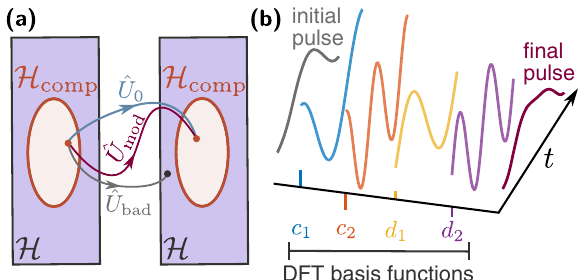
Fig. 1 Generic quantum control problem. a An idealized unitary evolution ( ^ U 0 ) maps an initial quantum state into a desired fi nal state. The real evolution ( ^ U ) does not allow one to reach the desired fi nal state because it gets spoil by unwanted interactions neglected when deriving ^ U 0 . The effects of these interactions can be made arbitrary small by modifying the idealized control fi elds ( ^ U mod ). b The idealized control fi elds are modi fi ed by adding a fi nite number of basis functions, e.g., discrete Fourier transform (DFT) basis functions, multiplied by free weights. The free weights are chosen such that the fi nal pulse averages away the effects of the unwanted